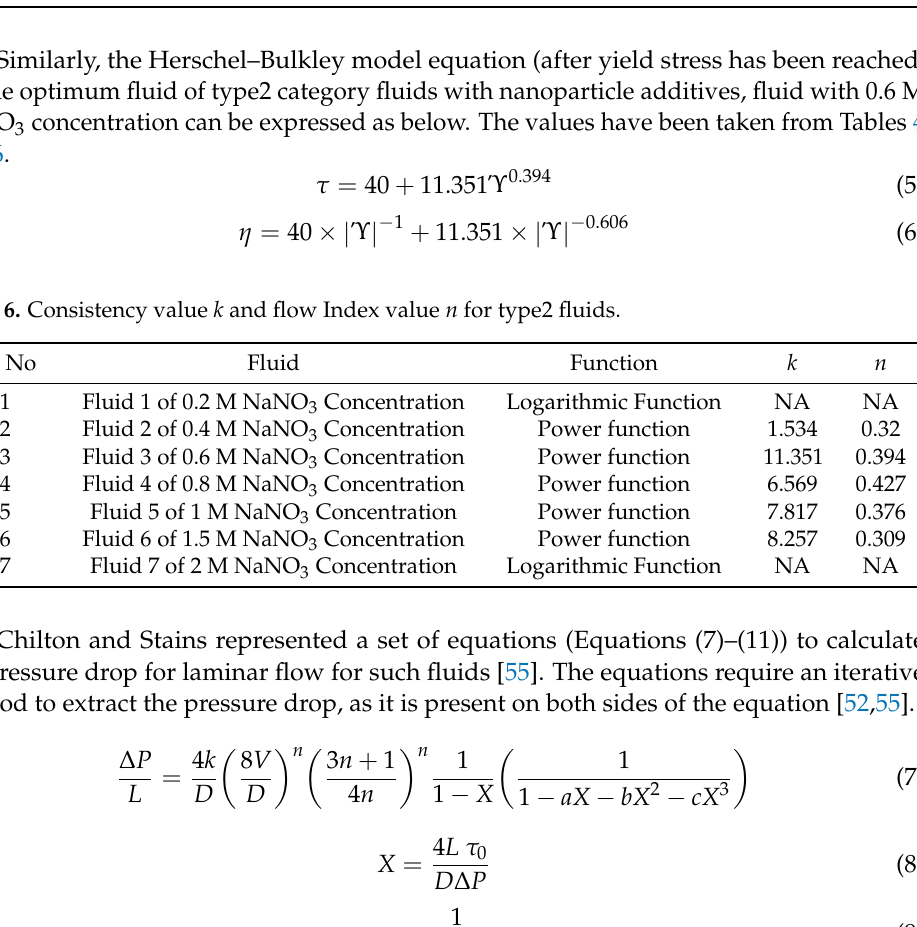
7 of 21 Figure 5. Comparison of viscosity plot of type1 viscoelastic fluids containing 0.8 M and 1.0 M NaNO 3 concentration at different temperatures. The statistical analysis of the plotted data gives different correlations between vis- cosity and shear rate with a considerable coefficient of determination values (see Table 1). Table 1. Regression functions for viscosity change with a varying shear rate of different viscoelas-